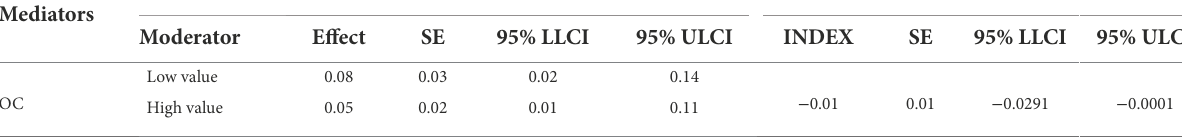
TABLE 3 Bootstrapping analysis results of the moderated